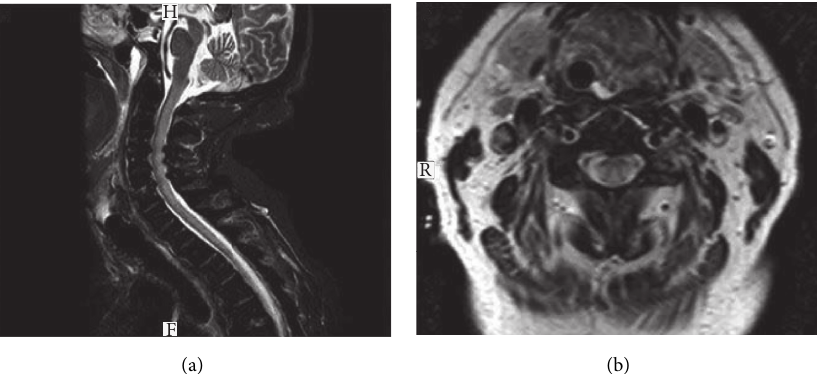
Figure 3: Short-tau inversion-recovery (STIR) sequence and T2: sagittal and axial slice. (a, b) extensive medullar hyperintensity of the lateral and posterior cords at levels C2-T1.